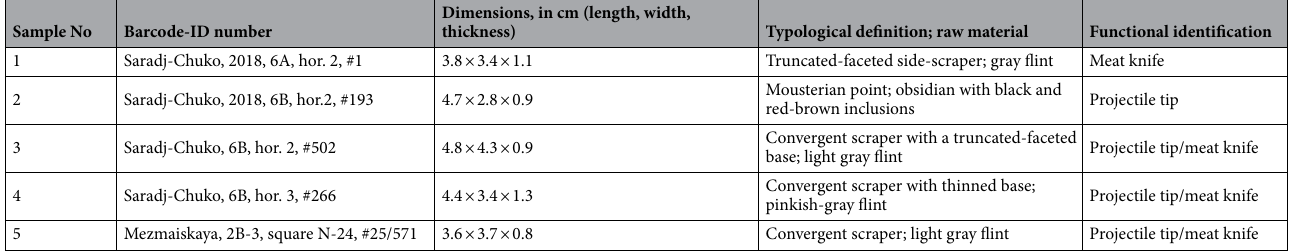
Table 1. Detail identification of the archaeological samples analyzed.